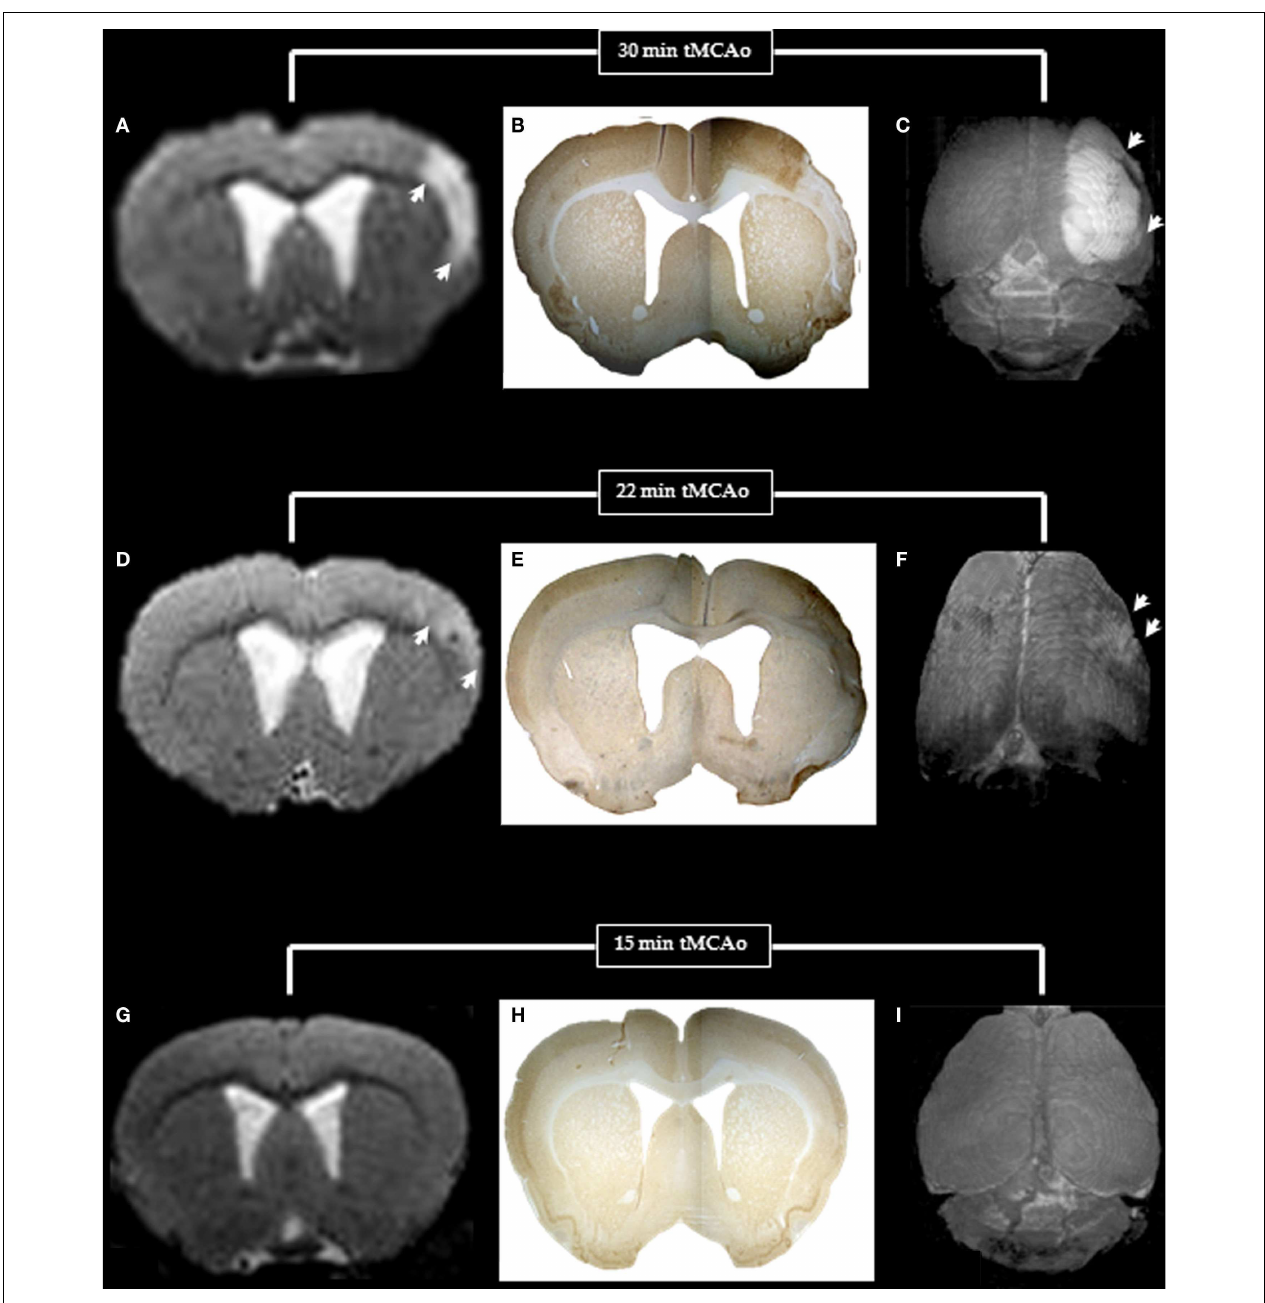
FIGURE 6 |T2-weighted MRI (left) and NeuN immunohistochemistry (middle) for one coronal section (bregma + 1.00mm), and surface renderedT2-weighted images (right) in typical rats with 30, 22, and 15min MCAo to illustrate the MRI and histopathological counterparts of pan-necrosis (A–C), partial infarction (D–F), and pure